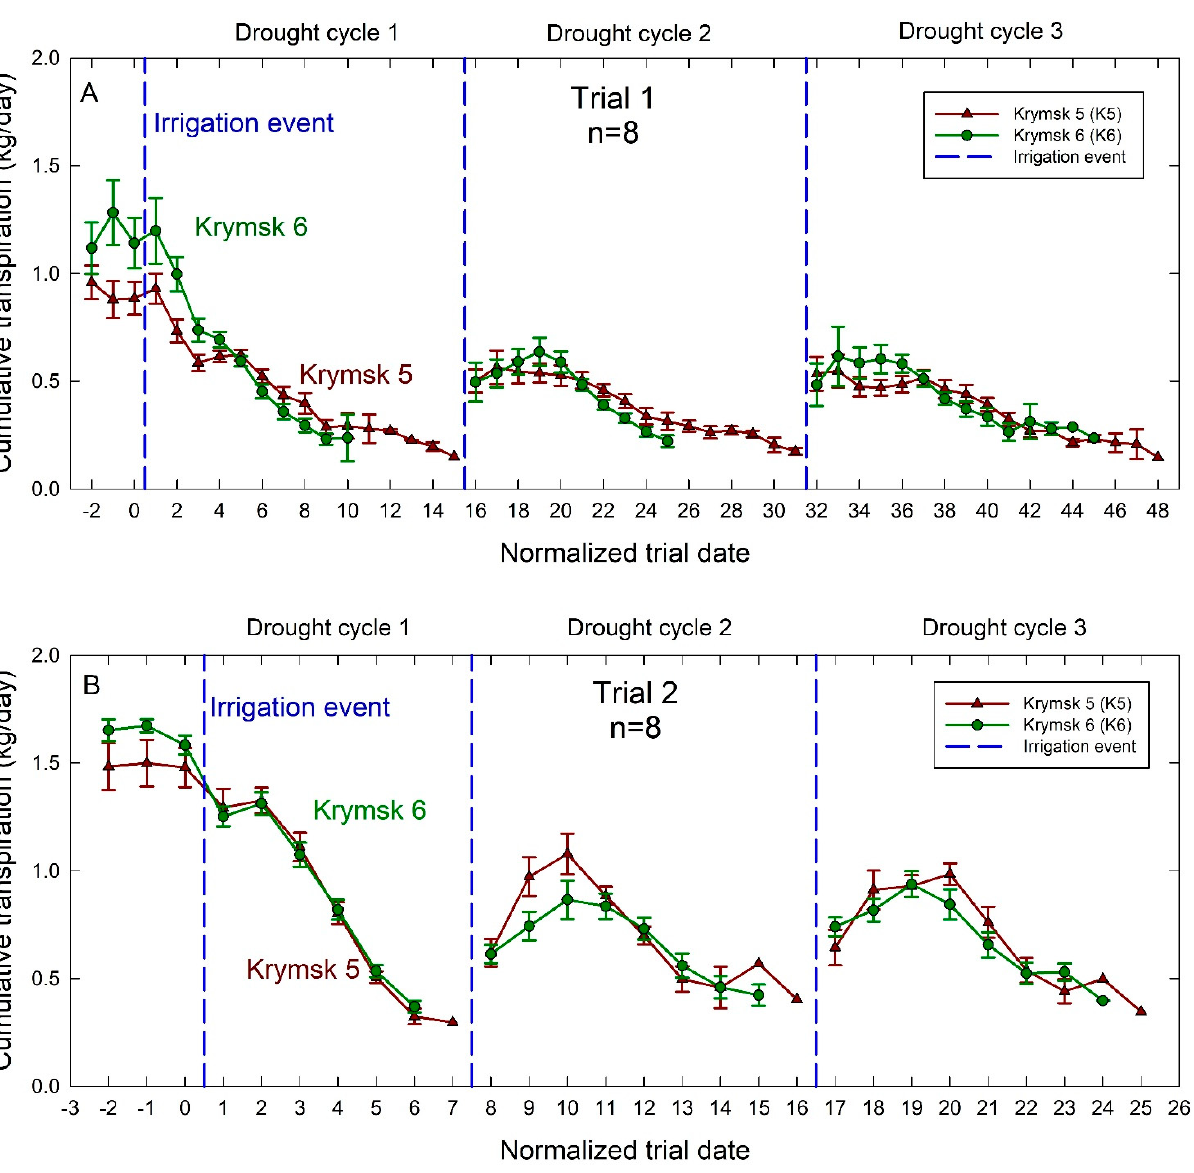
Figure 4. Average daily transpiration rates for Krymsk ® 5 (red triangles) and Krymsk ® 6 (green circles) rootstocks during Trial 1 ( A ) and Trial 2 ( B ). Rootstocks had water withheld until transpiration rates declined by 75% during Trial 1 ( top ), and 70% in Trial 2 ( bottom ). Once transpiration rates declined to these thresholds, irrigation ( blue dotted lines ) was independently triggered for each individual tree, returning the soil to field capacity. Normalized trial date is used based on when each tree began its drought cycle. Bars represent standard error from 8 replicate trees.